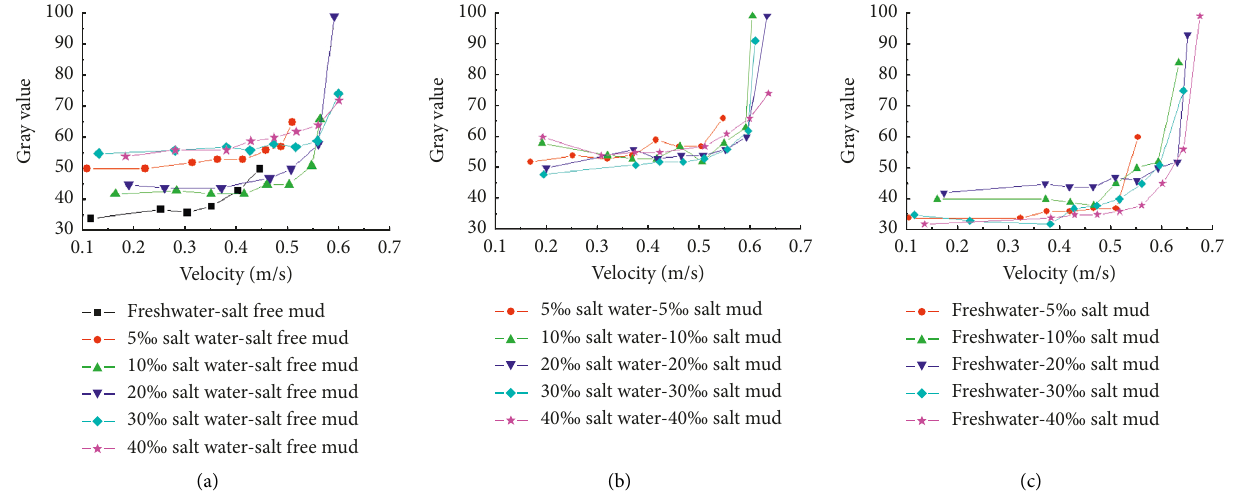
Figure 4: The gray level variation of water with flow velocity during the muddy clay onset. (a) Salt water-salt-free clay mud. (b) Salt water- salt clay mud. (c) Freshwater-salt clay